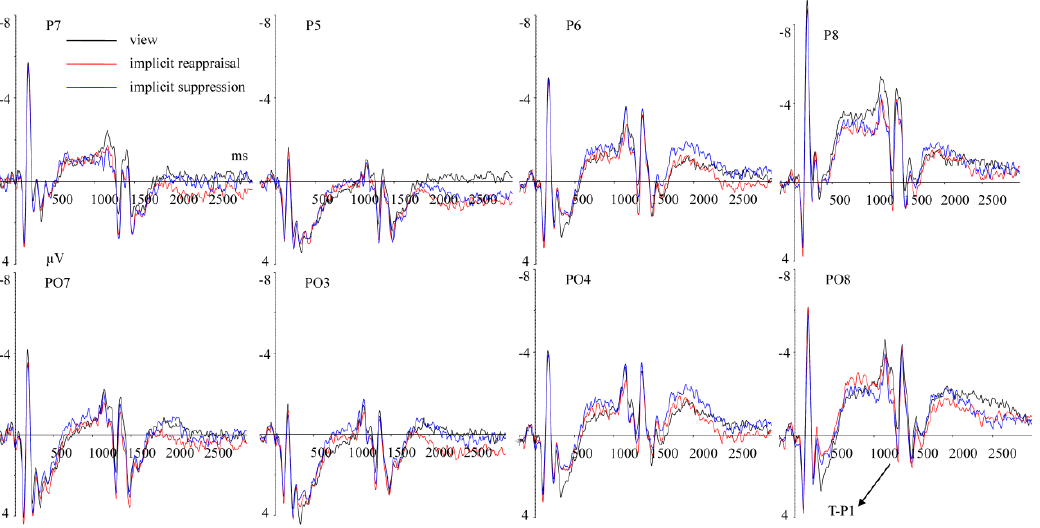
Figure 4. Grand average ERPs of T-P1 components elicited by completing the MCE task under view (black lines), implicit reappraisal (red lines), and implicit suppression (blue lines) conditions recorded at P5, P6, P7, P8, PO3, PO4, PO7, and PO8.